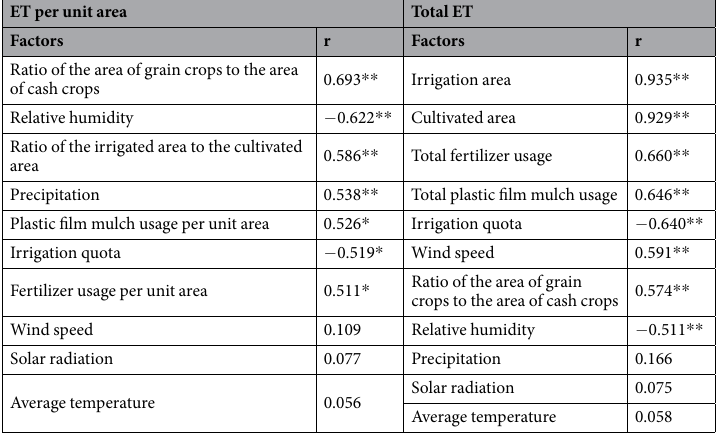
Table 3. Correlation coefficients (r) between ET per unit area, total ET and driving factors. * Denotes correlation is significant at 0.05 level; ** denotes correlation is significant at 0.01 level.